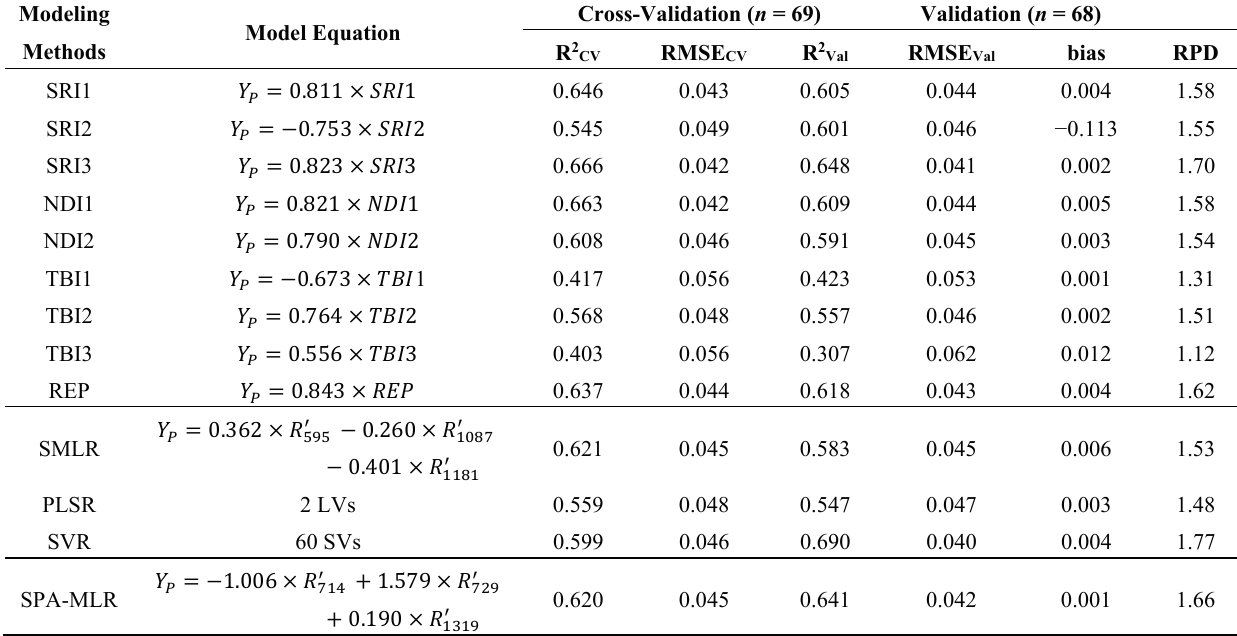
Table 5. Cross-validation and validation results of 13 modeling methods to estimate P contents at the canopy